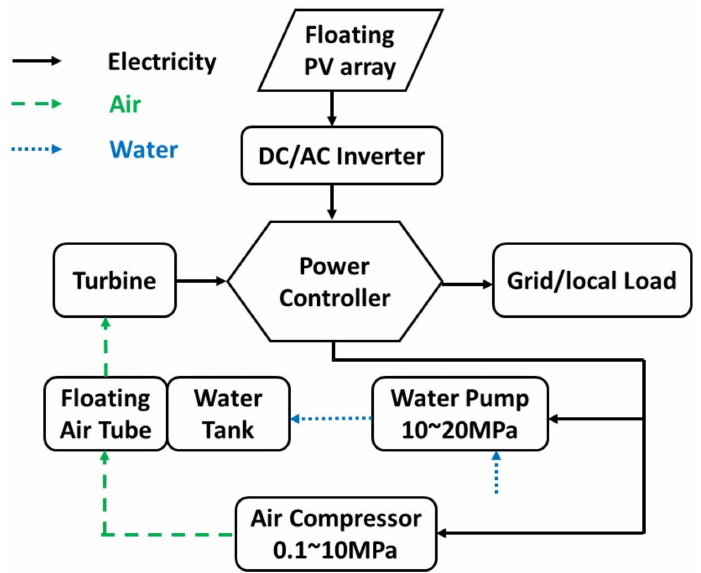
Figure 9. Block diagram of a floating PV system with compressed energy storage [75].